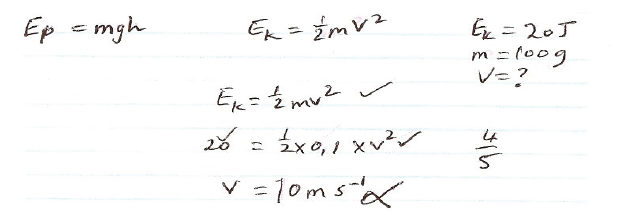
Figure 5 : The Science teacher’s use of